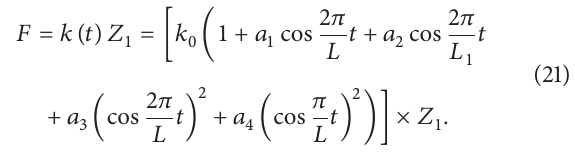
Figure 5: The performance of the active controller: (a) shows the reduction of variation in 𝑧 1 and (b) shows the attenuation of vibration transmission force in 𝑧 2 . The controller is turned on around